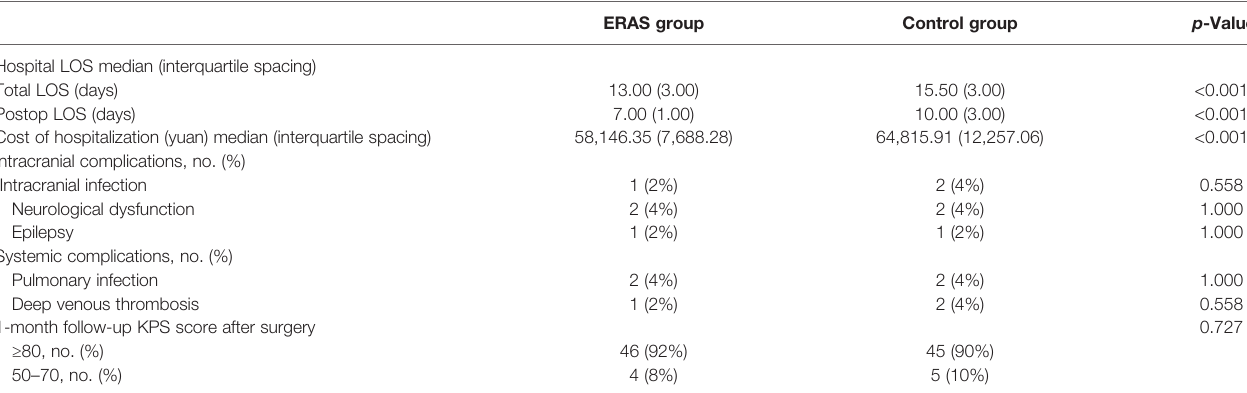
TABLE 6 | Analysis of median hospital LOS, cost of hospitalization, and prognosis of